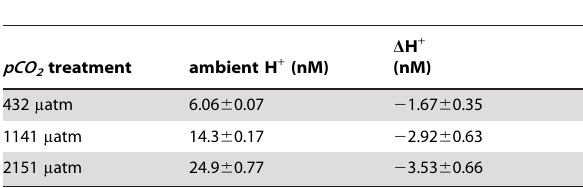
Table 4. Ambient H + concentrations and microenvironmental H + differences ( D H + ) of photosymbiotic foraminifera at saturated light conditions (mean 6